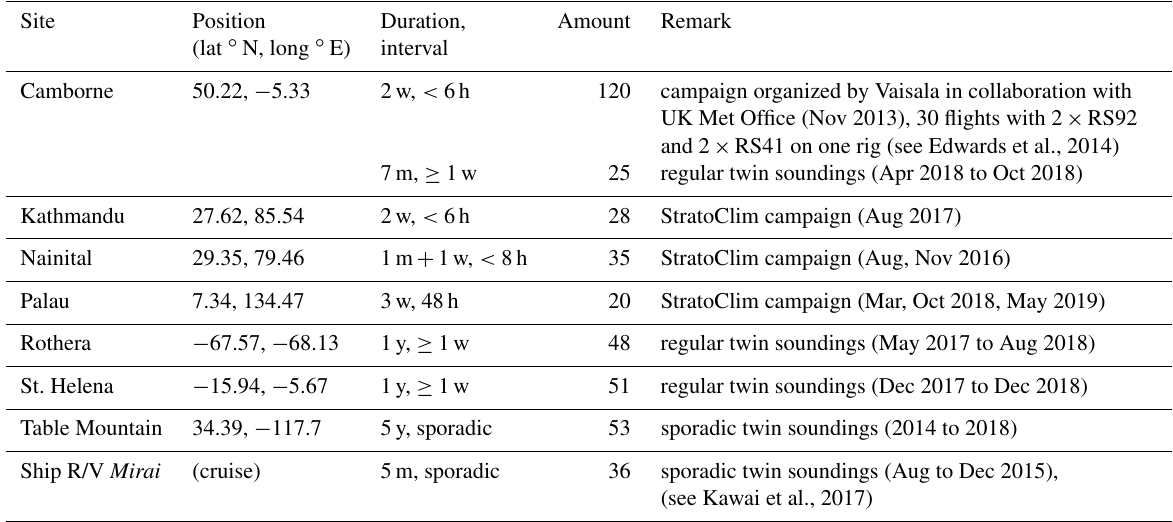
Table 2. Non-GRUAN sites that provided data from RS92–RS41 intercomparison flights to GRUAN (y – year, m – month, w – week, d – day, h –